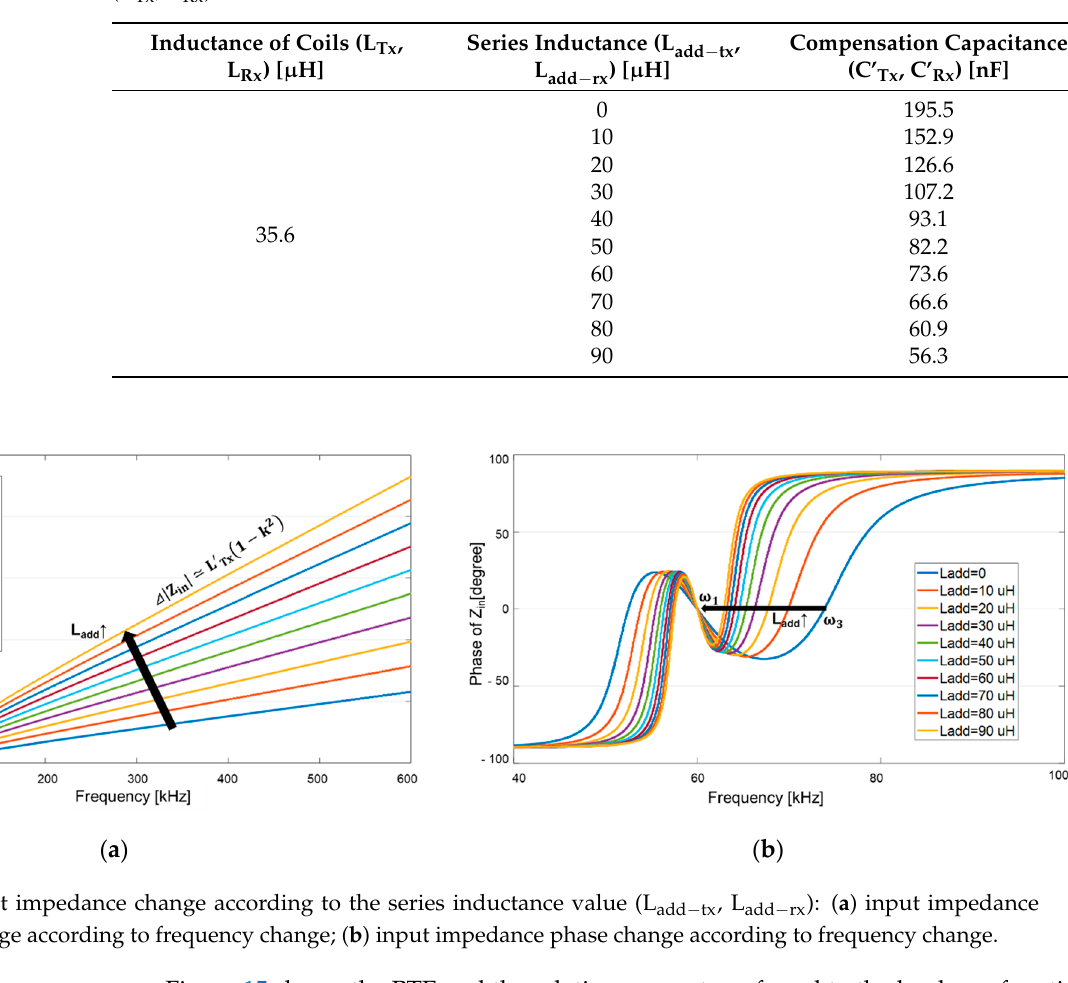
Table 7. Inductance of series inductors (L add ) and corresponding compensation capacitance values (C Tx , C Rx ).